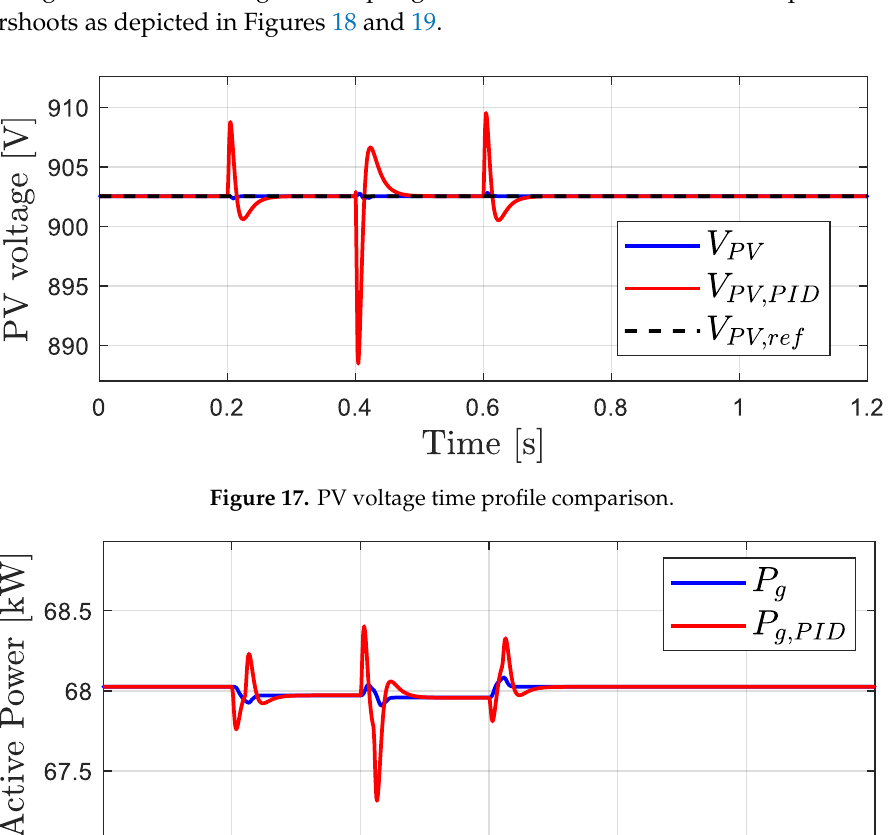
Figure 16. q -axis component of the inverter voltages vector e q(i) .